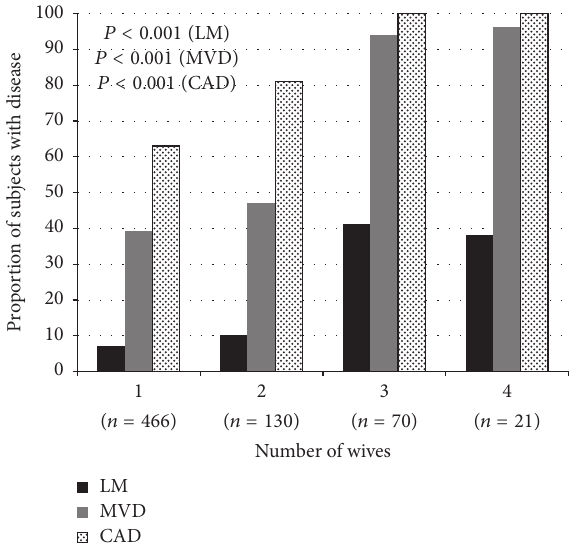
Figure 1: Relationship between number of wives and coronary angiogram